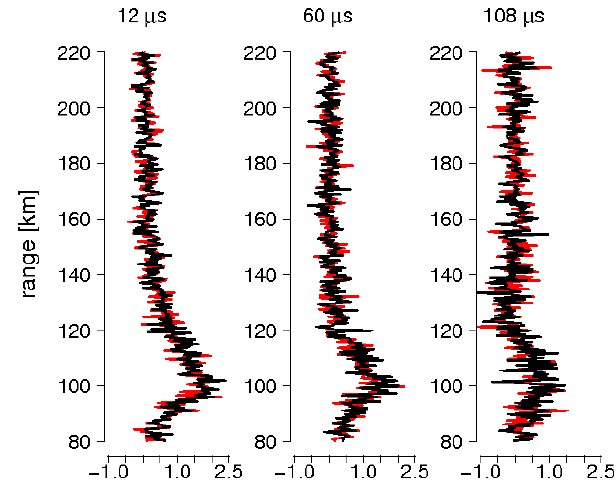
Fig. 3. Real parts of sample lag profiles at 12, 60 and 108µs from 25 November 2006. The decoding results are shown by red line and the inversion results by black line. The integration time is 6s, the range resolution is 450m and the ACF value is given in arbitrary